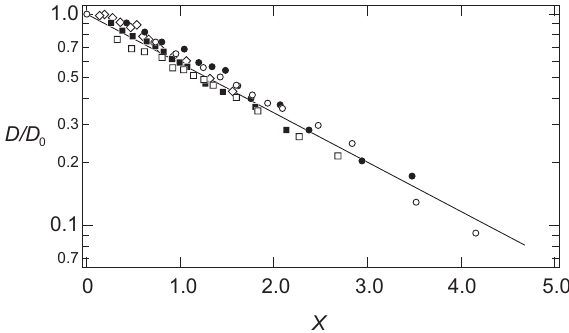
Figure 2. The normalized diffusion coefficient of the probe molecules in gel, D / D 0 , is plotted as a function of the scaling variable, x = M 1/3 ϕ 3/4 , in a semi-logarithmic manner. Symbols are the same as that of the Figure